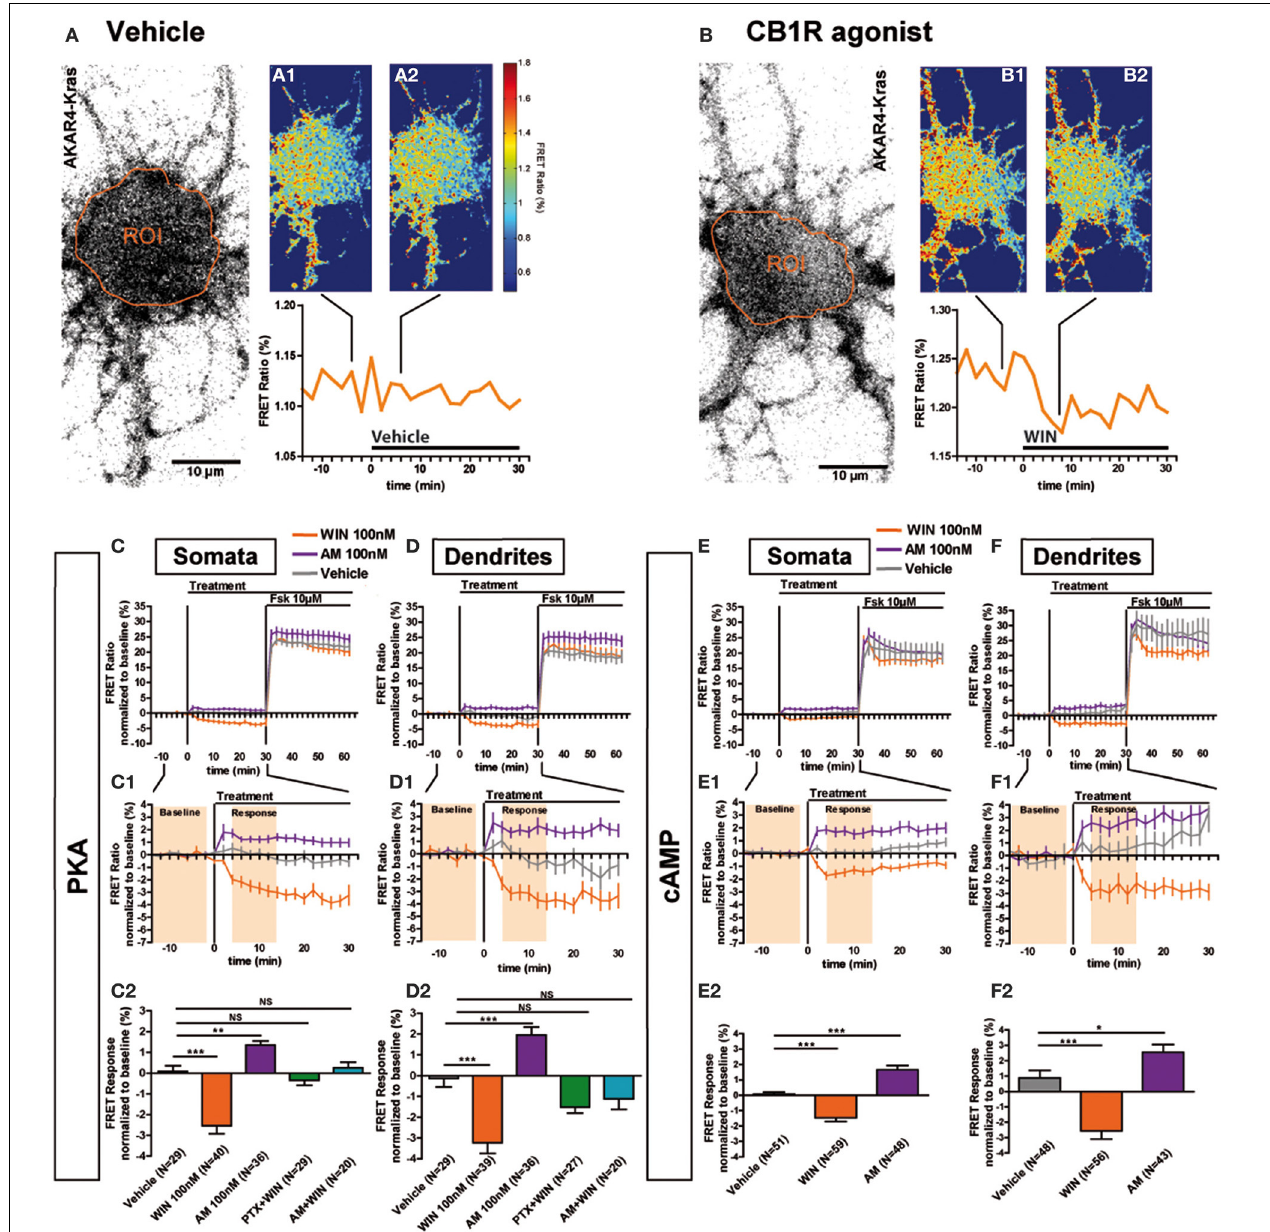
FIGURE 2 | Somatodendritic CB1Rs constitutively inhibit the cAMP/PKA pathway. (A,B) Two representative neurons expressing the membrane-targeted PKA sensor AKAR4-Kras. The first image of the acquisition on YFP channel with the ROI is shown (A,B) . The mean FRET ratio in somatic ROIs (orange) is shown at 4min (-t4) before (A 1 , B 1 ) and at 6min (t6) after the addition of treatment at t0: Vehicle (A 2 ) or agonist WIN55-212,2 (WIN) 100nM (B 2 ) . (C–F) Averaged responses of AKAR4-Kras (C,D) or the cAMP sensor T Epac VV expressing neurons (E,F) . The FRET ratio normalized to baseline was calculated for each neuron with a time-resolution of 2min, separately in somata and dendrites. The curves represent mean ± S.E.M. of the FRET ratio for all imaged neurons at each time point. Addition of agonist WIN 100nM but not of vehicle at t0 results in rapid FRET ratio decrease while inverse-agonist AM281 100nM (AM) treatment results in increased PKA-activation. At 30min, adenylyl-cyclase activator Forskolin (Fsk) was added at 10 μ M, inducing a